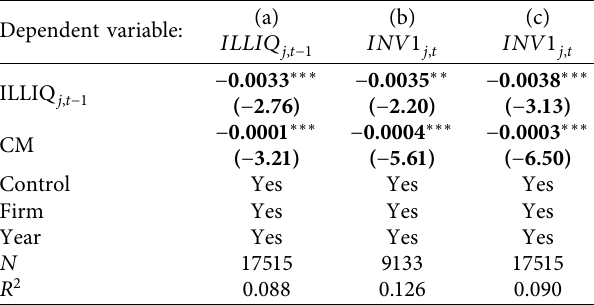
Table 10: Inspection of the information transmission